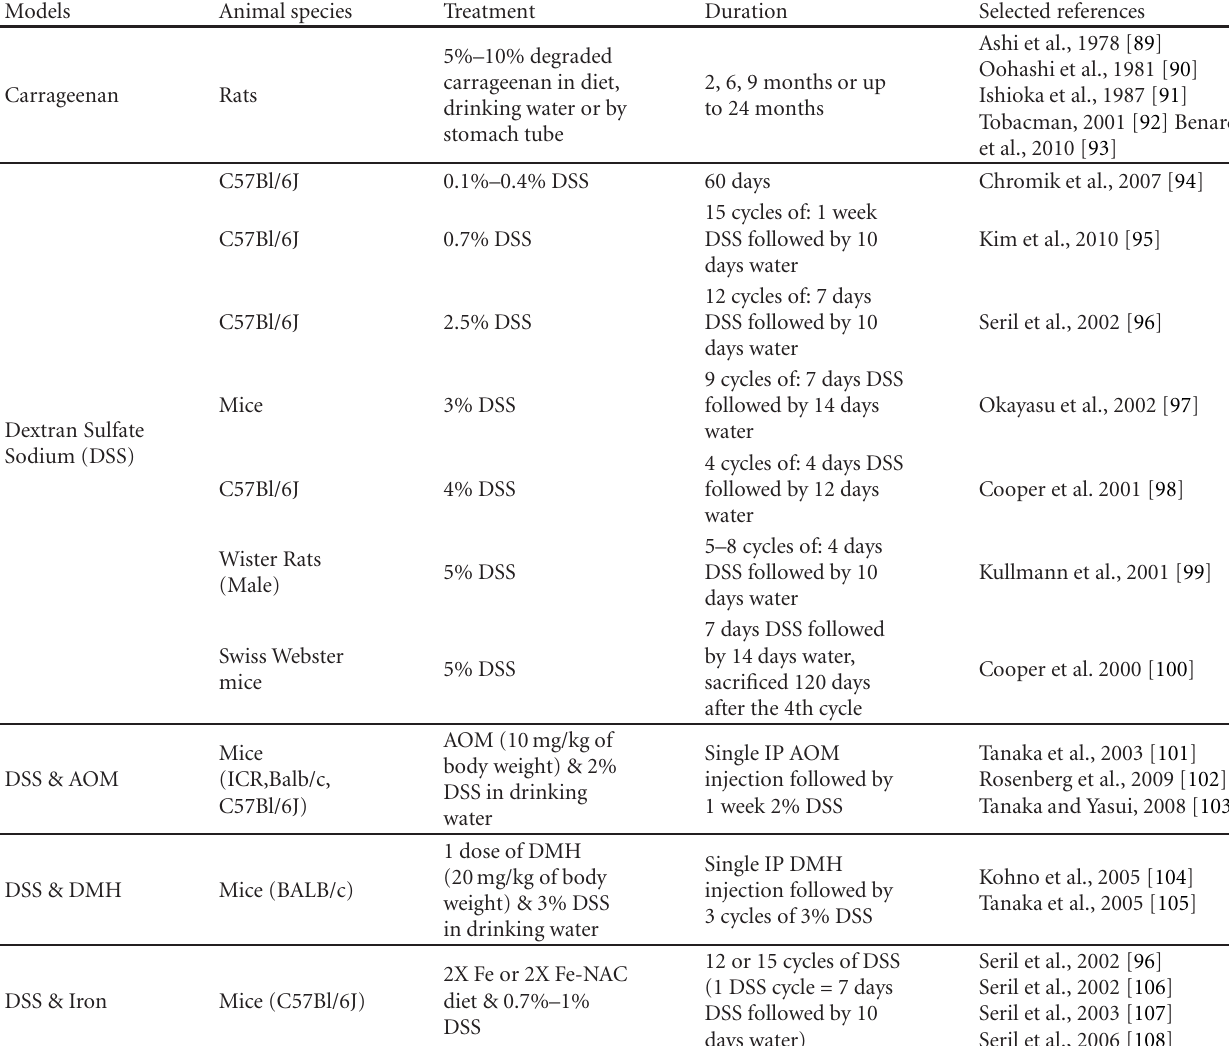
Table 2: Summary of CAC in chemically induced colitis